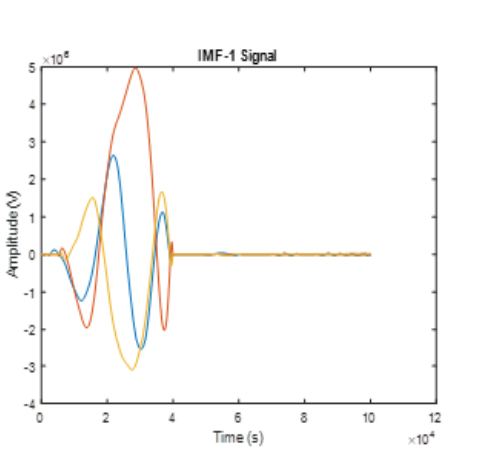
Figure 15. Waveforms of IMF 1 and instantaneous amplitude of phase A